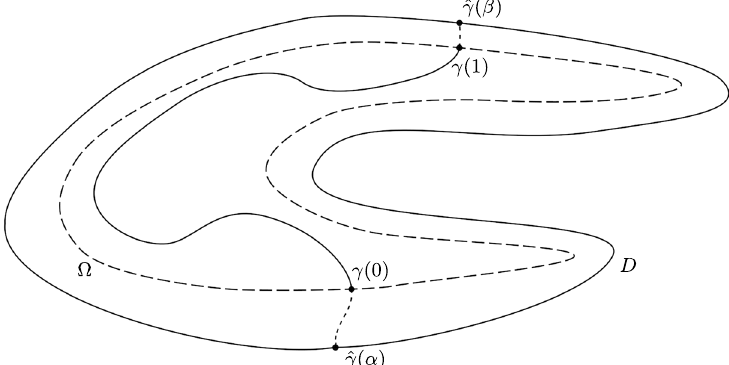
Figure 2: The setting of Theorem 1.9. The orthogonal Finsler geodesic chord γ in Ω can be extended to γ ˆ , which is a brake orbit in the potential well D , up to a time reparametrization. The extension is obtained through the unique geodesics that realize ψ γ 0 ( ( )) and ψ γ 1 ( ( ))